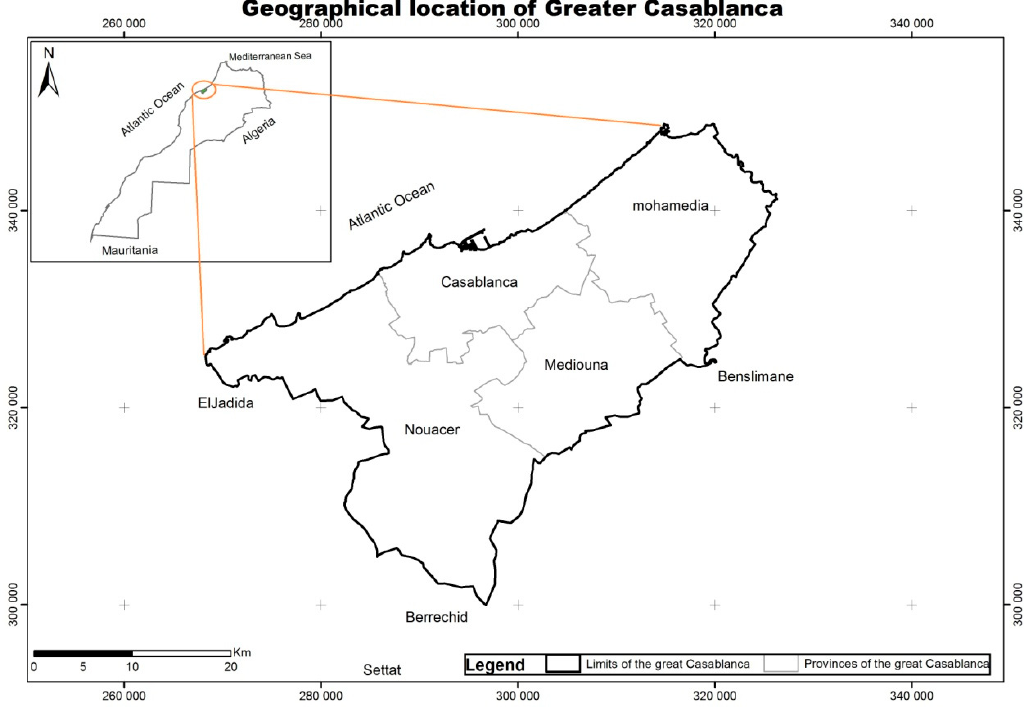
Figure 3. The geographical location of Casablanca.